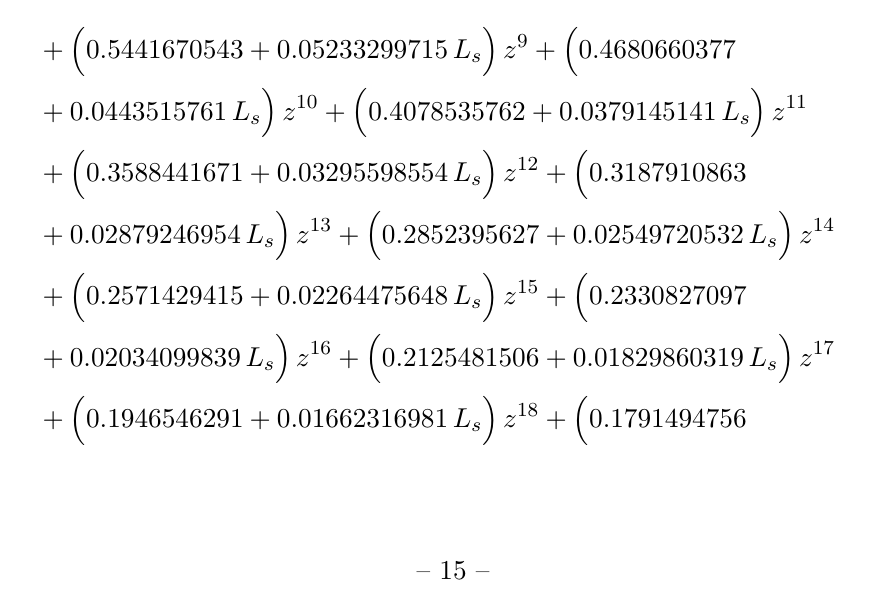
Figure 8 . Comparison of the high-energy expansion (HE) truncated at O (cid:0) (cid:1) O 1 =z 8 with the exact result for the three-loop coe(cid:14)cient of the (cid:12)nite remainder C (2) L (cid:22) = 0. The lower panel shows the absolute di(cid:11)erence between the expansions and the exact